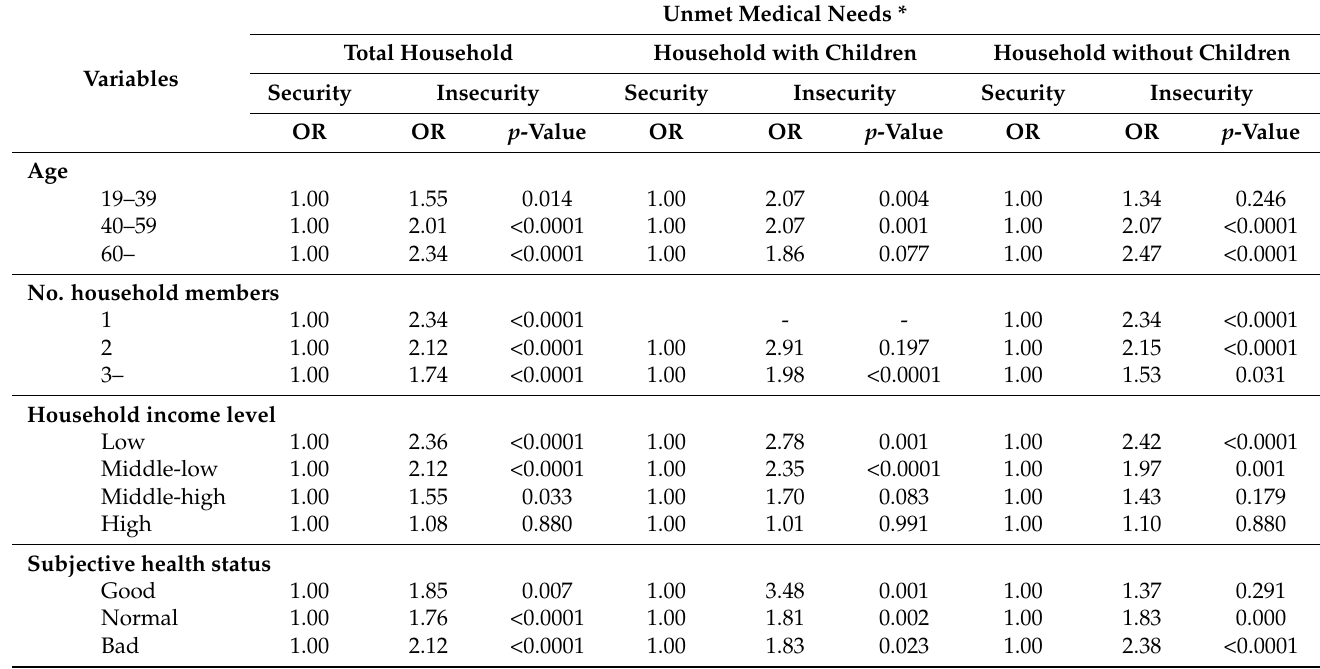
Table 3. Age and number of household members, household income level, subjective health status specific association of unmet medical